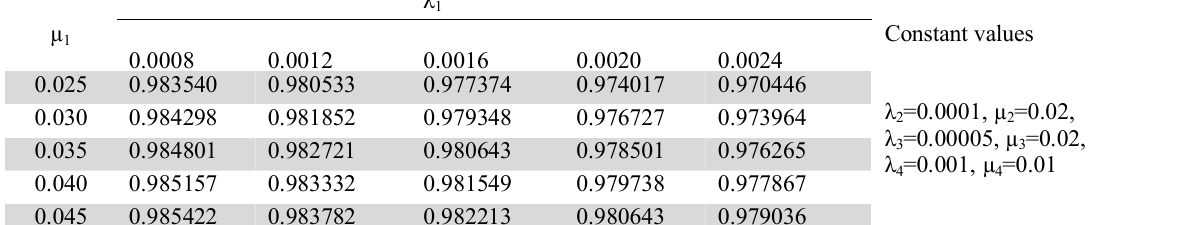
Effect of Failure and Repair Rates of Air heater on Availability (A